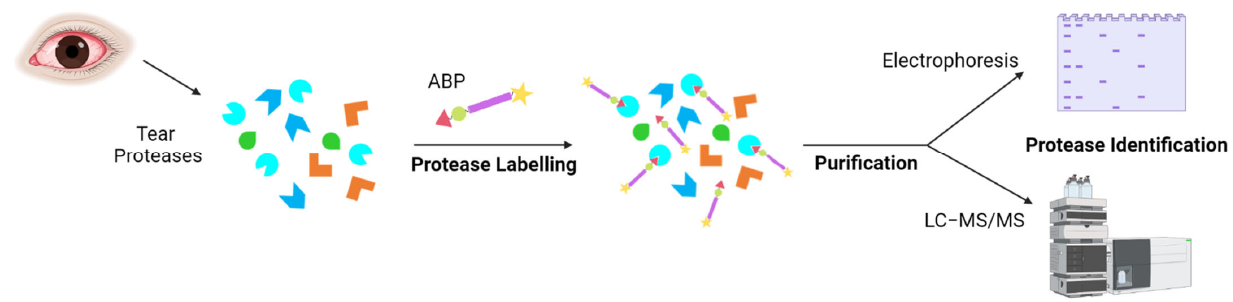
Figure 3. Tear protease identification by activity ‐ based protein probes (ABPs). Proteases present in DED patients are labelled with an ABP for a specific protease family. The reactive group of the ABP would bind to the active enzymes. The bound proteases can be isolated and analyzed by electrophoresis and/or mass spectrometry.